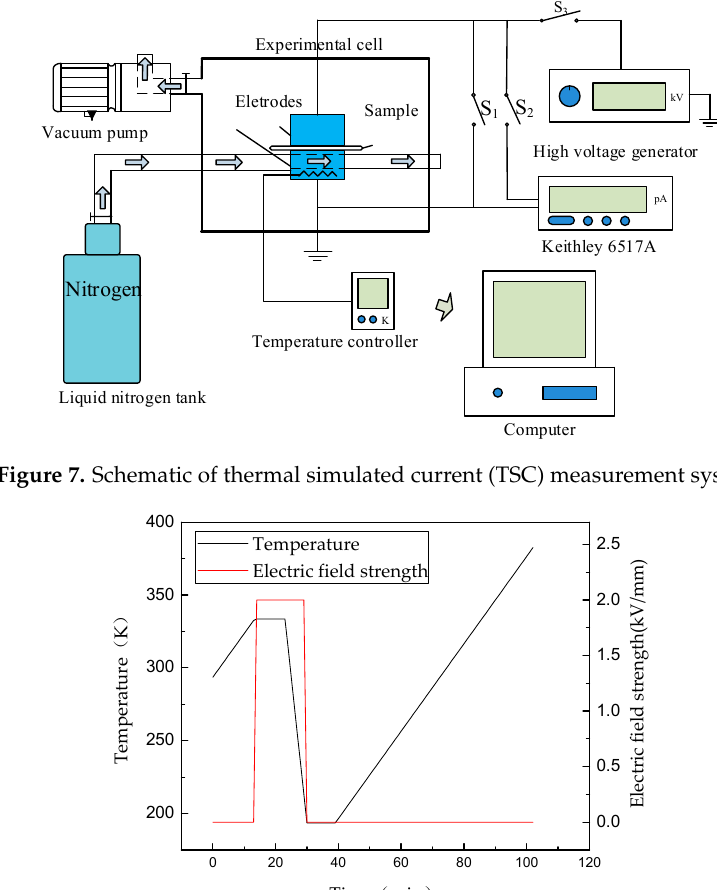
Figure 8. Curves of temperature and electric field stress versus time of TSC test.